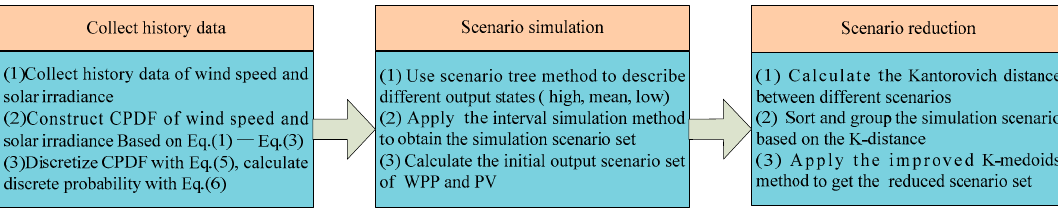
Figure 3. The uncertainty simulation flowchart. PV: photovoltaic power plant; WPP: wind power plant.